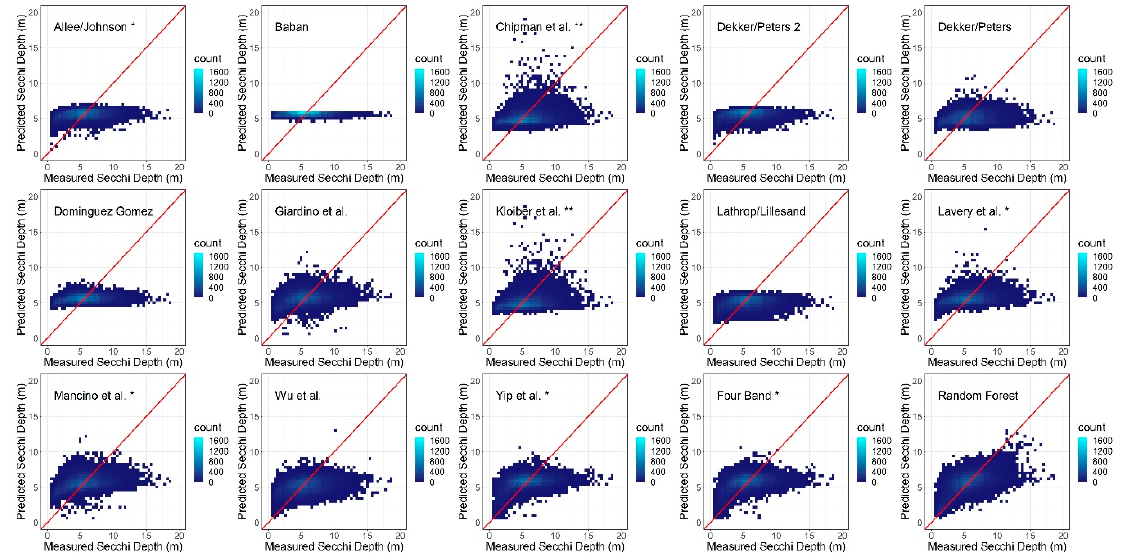
Figure 5. Training dataset model output for the overall dataset. Panels with a single asterisk (“*”) after the model indicate that there are values that are not displayed because there are negatively predicted Secchi. Panels with two asterisks (“**”) indicate that there are values that are not displayed because they are outside of the bounds of the limits displayed here (maximum Secchi depth displayed is 20m).